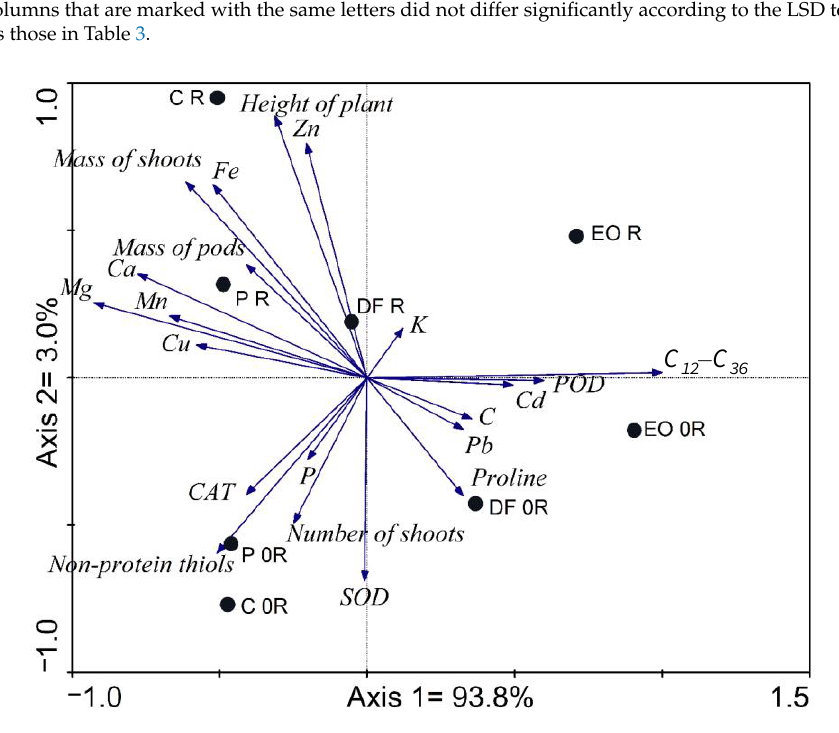
Figure 6. Principal component analysis that was performed on the broad bean biochemical parameters and content of elements in the plants that were grown in PDS-contaminated soils. The symbols are the same as those in Table 3.